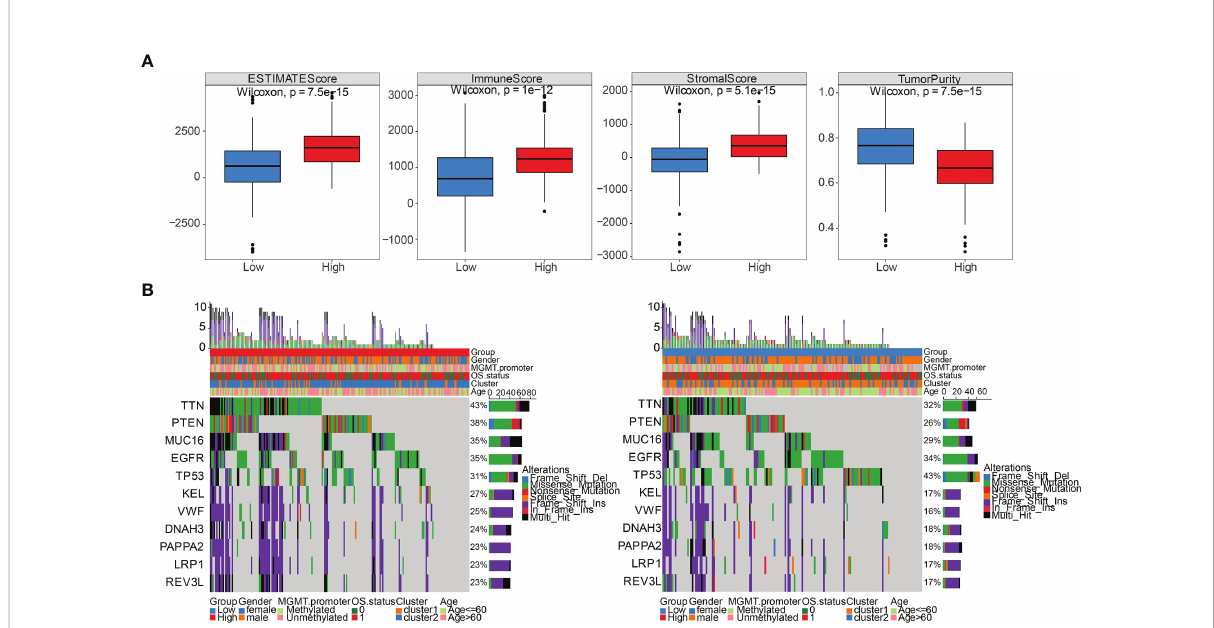
FIGURE 9 Comparison of immune stromal score and somatic cells mutation between high- and low-risk groups. (A) Differential distribution of estimate score, immune score, stromal score, and tumor purity between high- and low-risk groups. (B) 11 genes with mutation frequency in the top 20 simultaneously appeared in the high-risk group (left panel) and low-risk group (right panel).